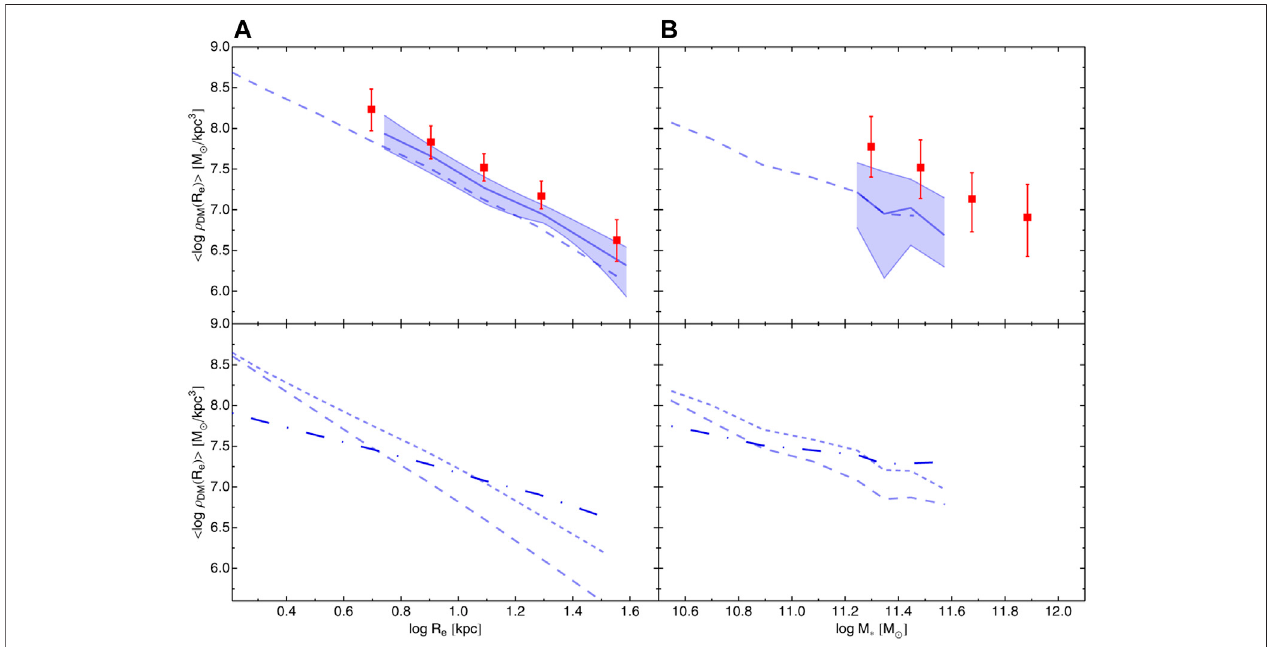
FIGURE3| Average(log)DMdensityasafunctionof R e (A) and M p (B) .InthetoppanelstheKiDSdatainredarecomparedwiththeSPIDERdatainthesamemass range. The dashed lines are plotted considering SPIDER galaxies with log M p / M ⊙ > 10.5 dex. g-band rest-frame structural parameters are used. In the bottom panel, instead, we focus on the SPIDER datasets. K-band structural parameters are used. Short- and long-dashed lines are the medians for a SIS and a constant-M/L. The point-dashed line is the result obtained fi tting a NFW for DM halo and a free